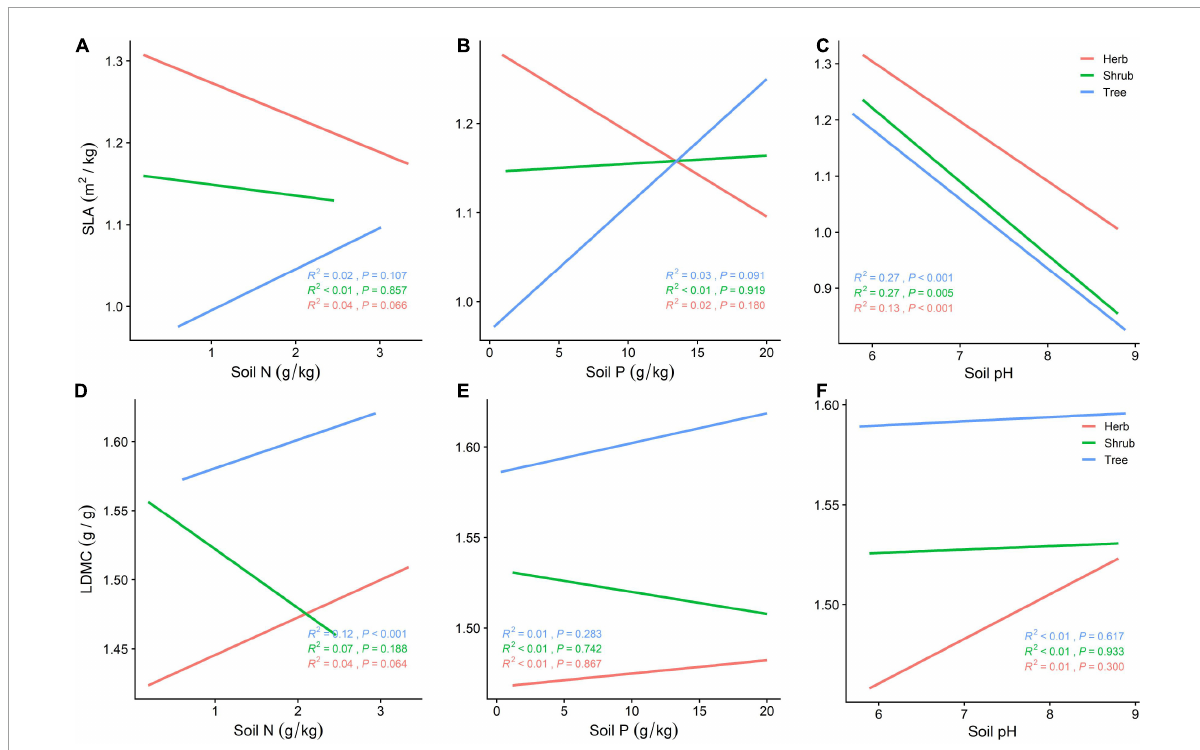
FIGURE5 (A) General linear relationship between Soil N and SLA of plants in the trees, shrubs, and herbs; (B) general linear relationship between Soil P and SLA of plants in the trees, shrubs, and herbs; (C) general linear relationship between Soil pH and SLA of plants in the trees, shrubs, and herbs; (D) general linear relationship between Soil N and LDMC of plants in the trees, shrubs, and herbs; (E) general linear relationship between Soil P and LDMC of plants in the trees, shrubs, and herbs; (F) general linear relationship between Soil pH and LDMC of plants in the trees, shrubs, and